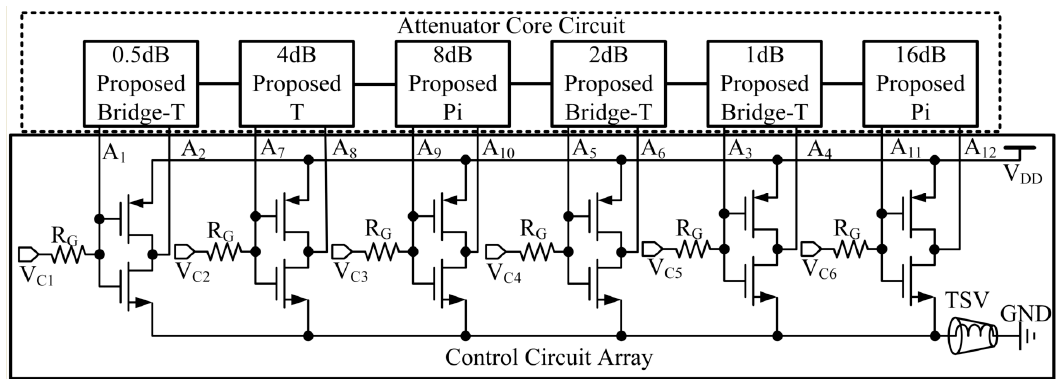
Figure 9. The block diagram of the proposed 6-bit digital control step attenuator.